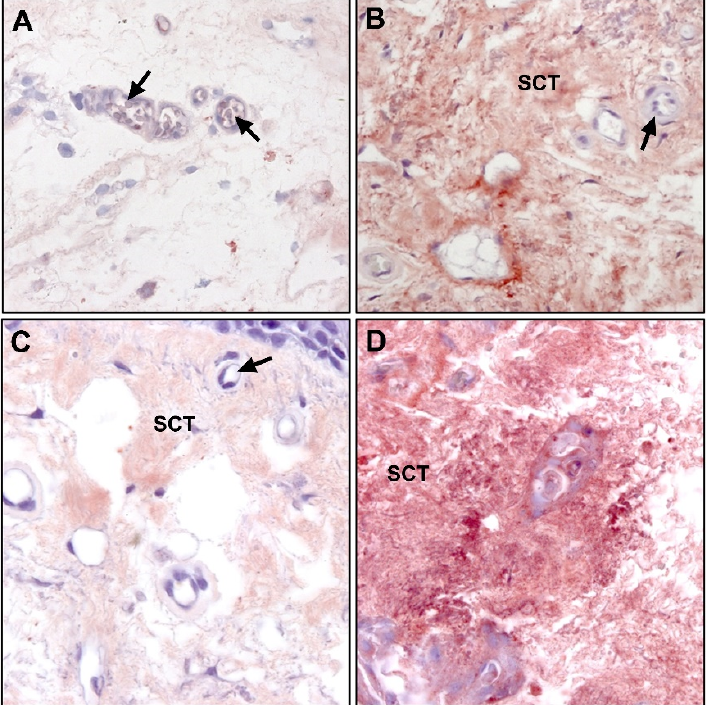
Figure 9. Expression of fibulin-2 localized in the subepithelial connective tissue in both ( A ) con- junctival and ( B ) pterygium tissue ( × 630); ( C ) fibulin-3 expression in conjunctival sample ( × 630); ( D ) positive labeling for fibulin-3 in pterygium tissue ( × 630). Higher expression levels of fibulin- 2 and fibulin-3 were observed in pterygium with respect to the conjunctiva. (SCT, subepithelial connective tissue; → , blood